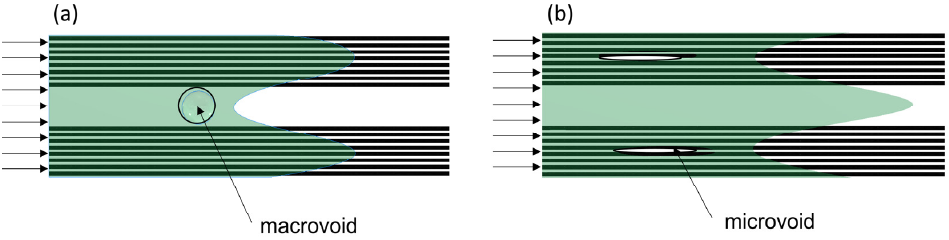
Figure 2. Formation of voids in the dual-scale model; ( a ) Formation of spherical macrovoids in the channels between the tows; ( b ) Formation of elongated microvoids inside the tows. With the help of the modified capillary number during injection, in conjunction with formation in the component [12–15,19].